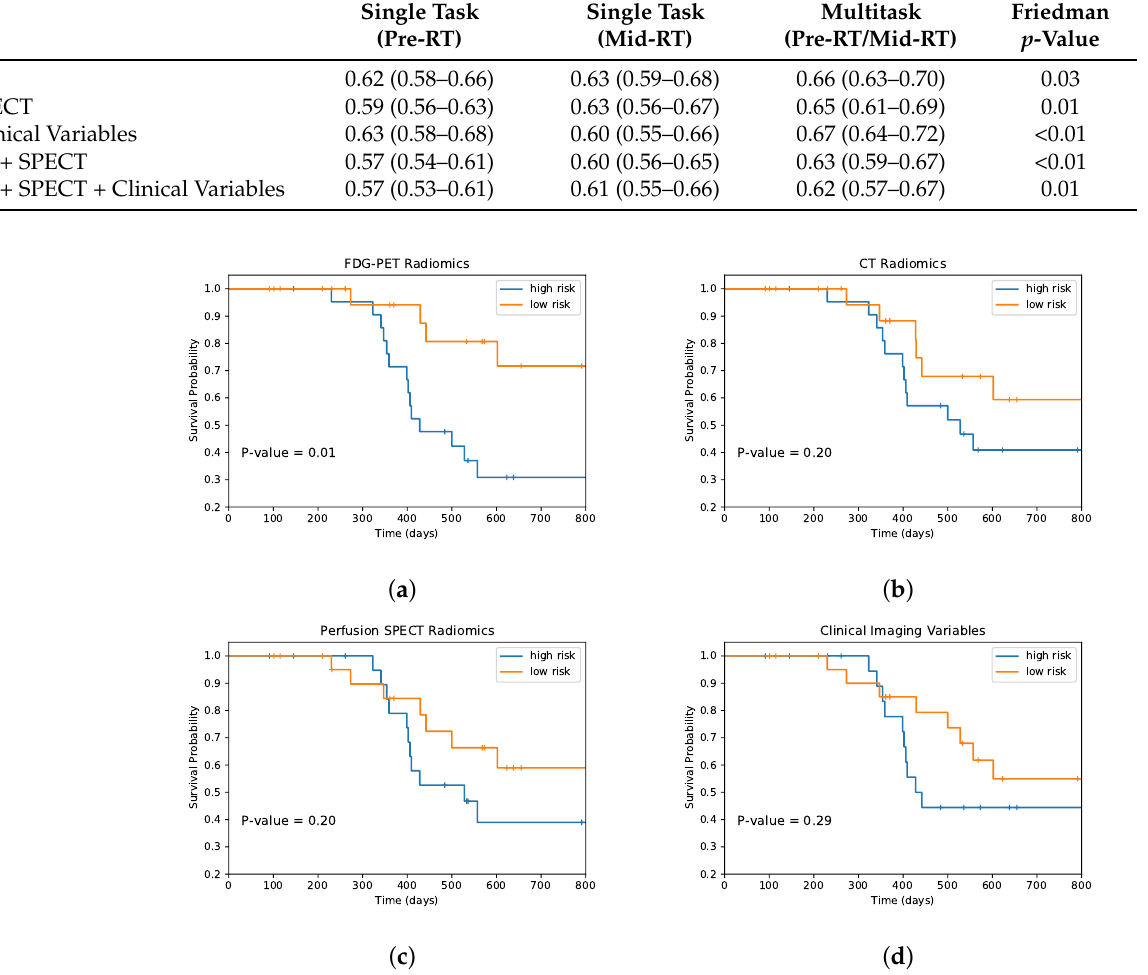
Figure 4. Kaplan–Meier curves of overall survival in test folds stratified by high-risk (>median prediction) versus low-risk (<median prediction) groups with models using the ( a ) FDG-PET, ( b ) CT, ( c ) perfusion SPECT radiomic features, and ( d ) clinical imaging